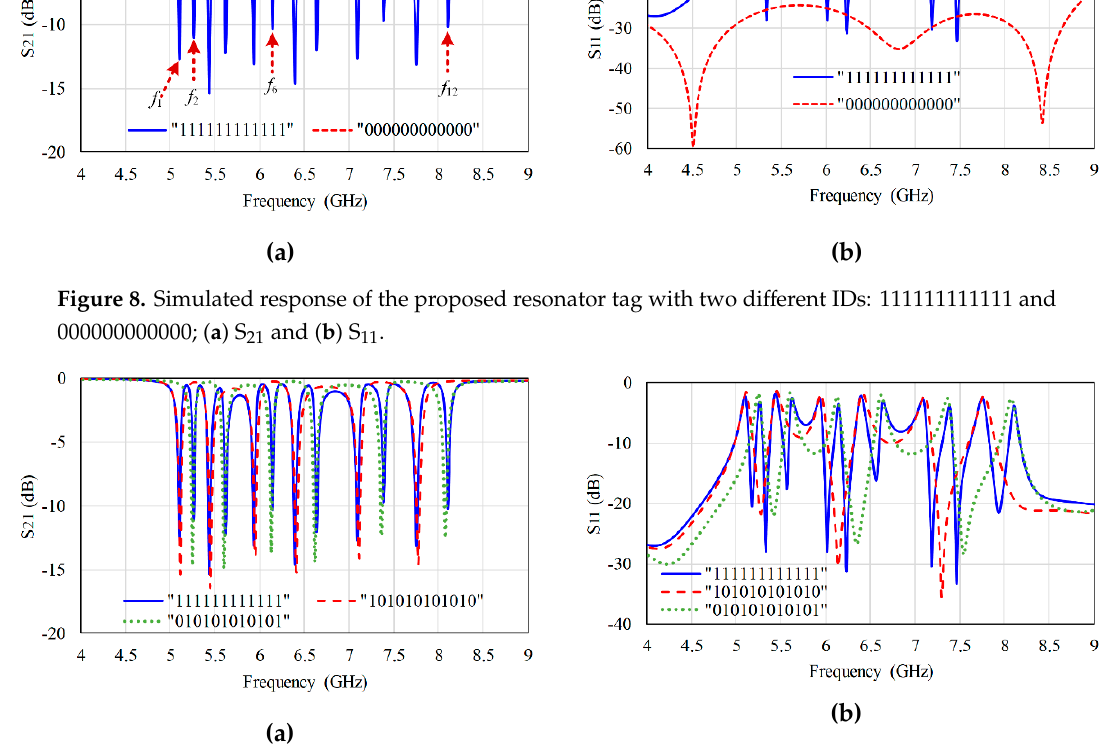
Figure 9. Simulated results of the proposed tag with three different codes: 111111111111, 101010101010, and 010101010101; ( a ) S 21 and ( b ) S 11 .